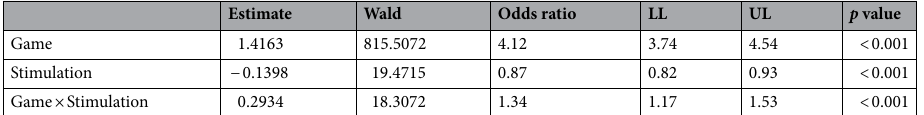
Estimate Wald Odds ratio